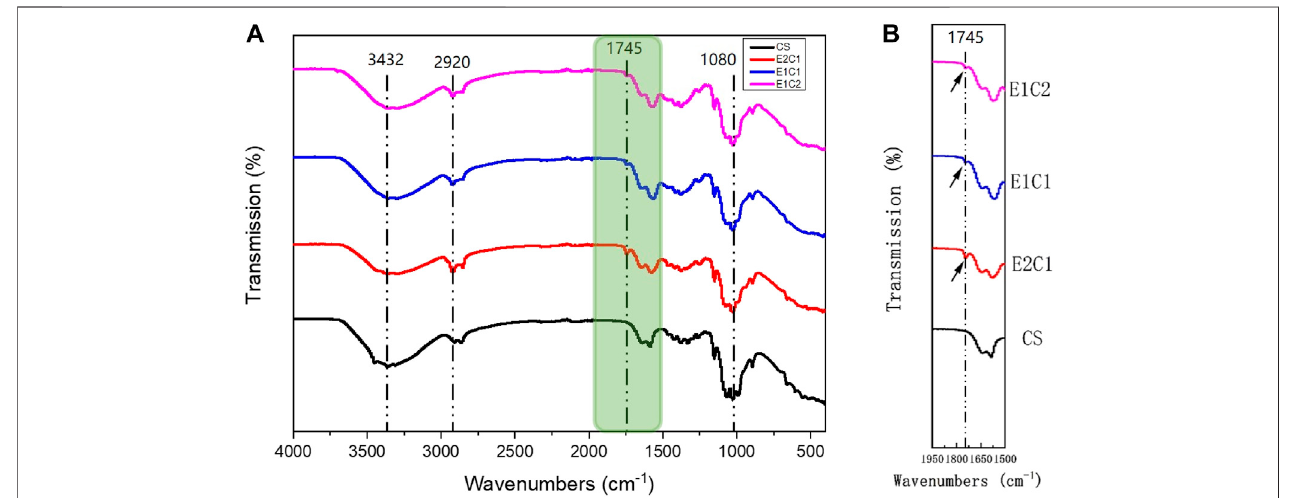
Frontiers in Bioengineering and Biotechnology |